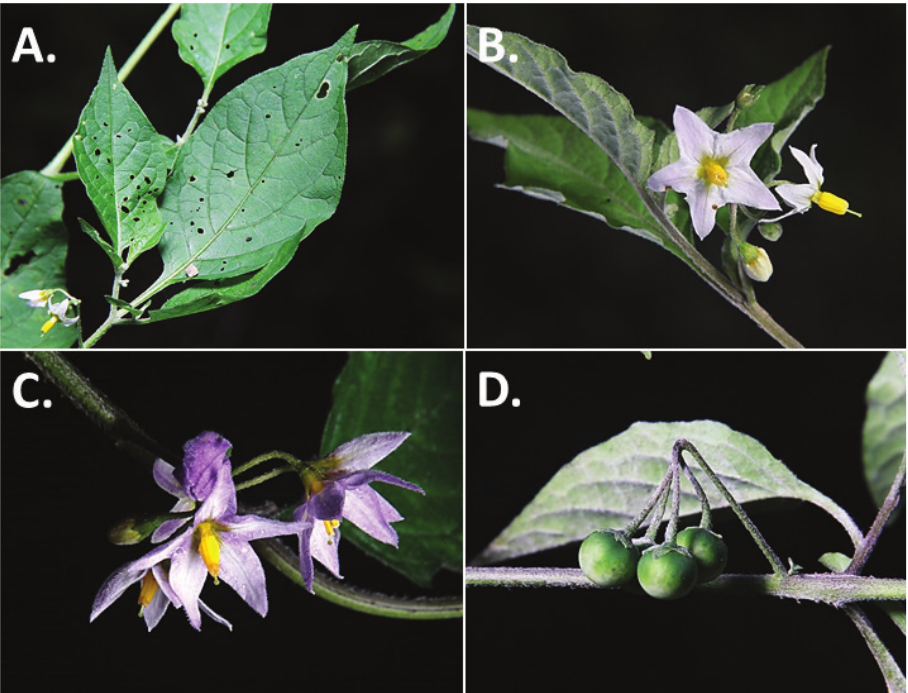
Figure 28. Solanum nigrescens M.Martens & Galeotti. A Leaves B flowering branch C inflorescence with flowers at full anthesis D developing fruits ( A–D Amith F0055 ). Photos by M. Gorostiza